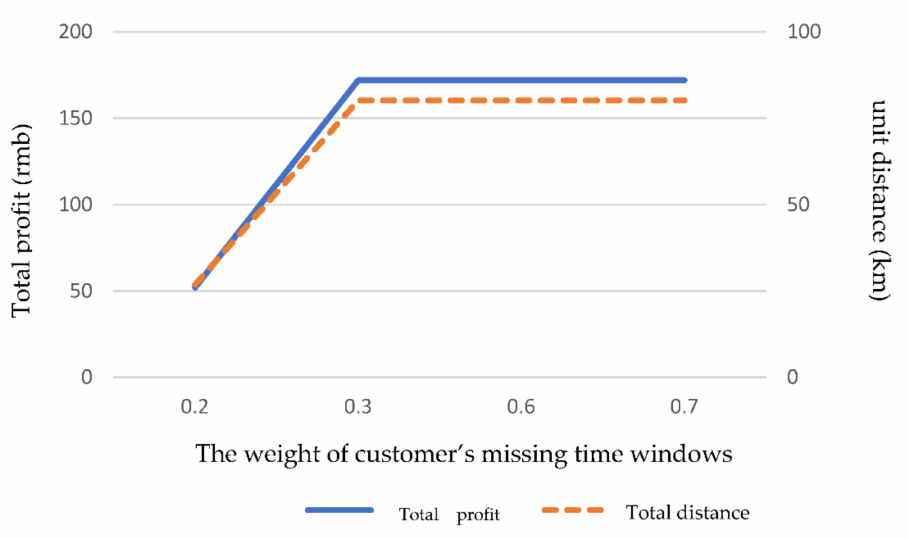
Figure 8. The result of the relationship between the weight of missed time windows and the profit and total route distance under the logistics service provider’s